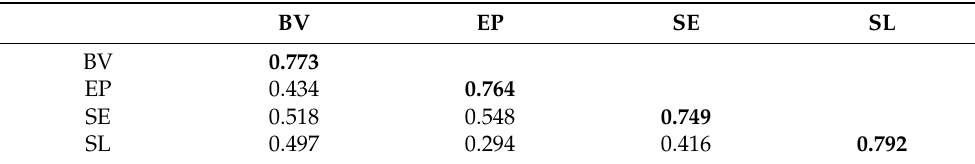
Table 2. Fornell and Lacker criterion using inter correlation matrix of constructs.